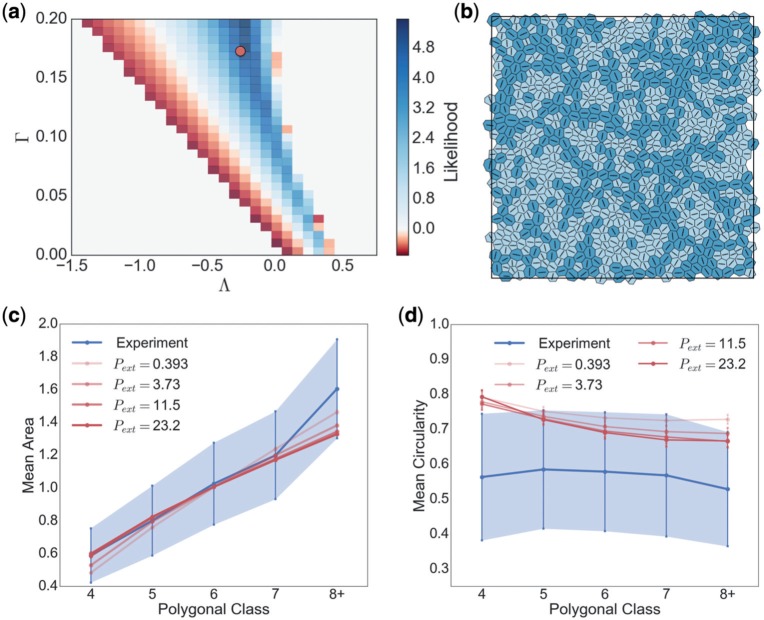
Results of parameter fitting. (a) Heat map showing value of the likelihood function (4.1) across a uniform grid in valid parameter space. The simulated monolayers used were the same as those in Figs 6 and 7. For each monolayer, the mean areas per polygonal class were calculated and used to evaluate (4.1). The likelihood was maximized at \documentclass[12pt]{minimal}
\usepackage{amsmath}
\usepackage{wasysym} 
\usepackage{amsfonts} 
\usepackage{amssymb} 
\usepackage{amsbsy}
\usepackage{upgreek}
\usepackage{mathrsfs}
\setlength{\oddsidemargin}{-69pt}
\begin{document}
}{}$(\Lambda, \Gamma)\approx (-0.26, 0.17)$\end{document}, marked by the circular symbol; a corresponding monolayer is shown in (b), with cells having \documentclass[12pt]{minimal}
\usepackage{amsmath}
\usepackage{wasysym} 
\usepackage{amsfonts} 
\usepackage{amssymb} 
\usepackage{amsbsy}
\usepackage{upgreek}
\usepackage{mathrsfs}
\setlength{\oddsidemargin}{-69pt}
\begin{document}
}{}$P_\alpha^{\text{eff}}>0$\end{document} (\documentclass[12pt]{minimal}
\usepackage{amsmath}
\usepackage{wasysym} 
\usepackage{amsfonts} 
\usepackage{amssymb} 
\usepackage{amsbsy}
\usepackage{upgreek}
\usepackage{mathrsfs}
\setlength{\oddsidemargin}{-69pt}
\begin{document}
}{}$<0$\end{document}) shaded dark (light). (c, d) Distributions of area and circularity across polygonal classes for simulations with \documentclass[12pt]{minimal}
\usepackage{amsmath}
\usepackage{wasysym} 
\usepackage{amsfonts} 
\usepackage{amssymb} 
\usepackage{amsbsy}
\usepackage{upgreek}
\usepackage{mathrsfs}
\setlength{\oddsidemargin}{-69pt}
\begin{document}
}{}$(\Lambda^\dagger,\Gamma^\dagger)=(-0.259,0.172)$\end{document} for increasing values of \documentclass[12pt]{minimal}
\usepackage{amsmath}
\usepackage{wasysym} 
\usepackage{amsfonts} 
\usepackage{amssymb} 
\usepackage{amsbsy}
\usepackage{upgreek}
\usepackage{mathrsfs}
\setlength{\oddsidemargin}{-69pt}
\begin{document}
}{}$P_{\mathrm{ext}}$\end{document}. (Colour in online.)